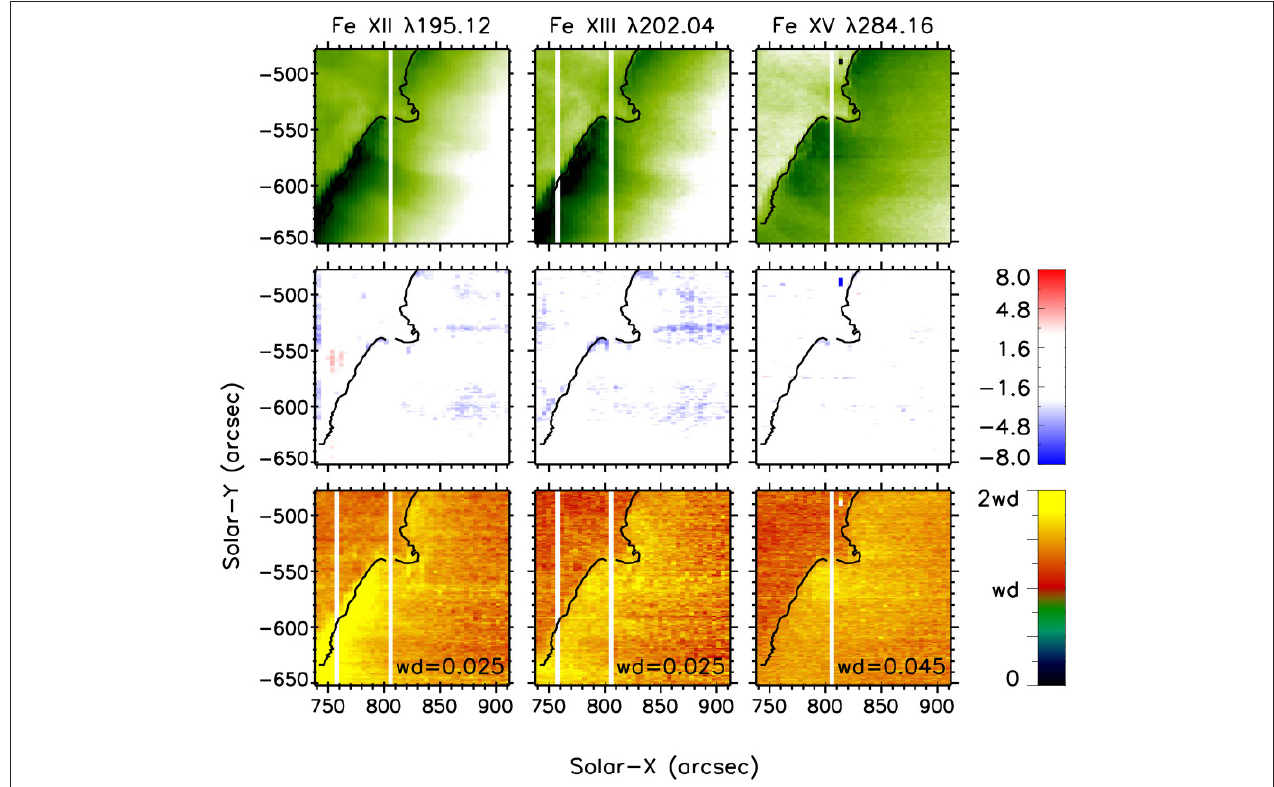
FIGURE 3 | A subfield of the EIS raster scan starting from the left at 18:16 UT and finishing at 19:21 UT. Top row : EIS intensity (inverse log) for Fe XII 195.12 Å, Fe XIII 202.04 Å, and Fe XV 284.16 Å. Middle row : Doppler velocity maps for the three lines. Bottom row : Line widths of the given lines with the median line width (wd) given in each window. The white stripes are regions of missing